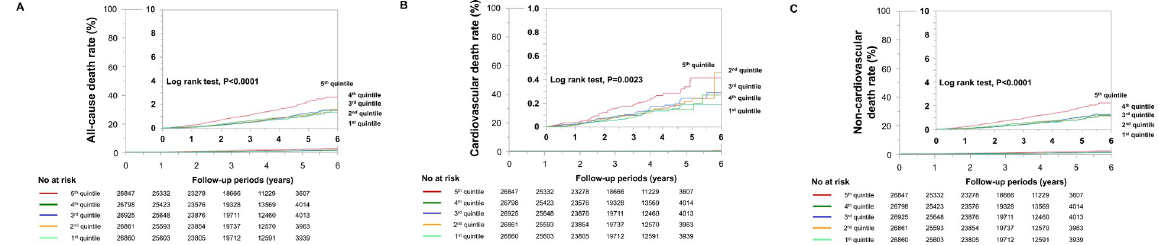
Fig 4. Kaplan–Meier analysis of all-cause deaths (A), cardiovascular deaths (B), and non-cardiovascular deaths (C) among quintiles based on the 1-year change in plasma